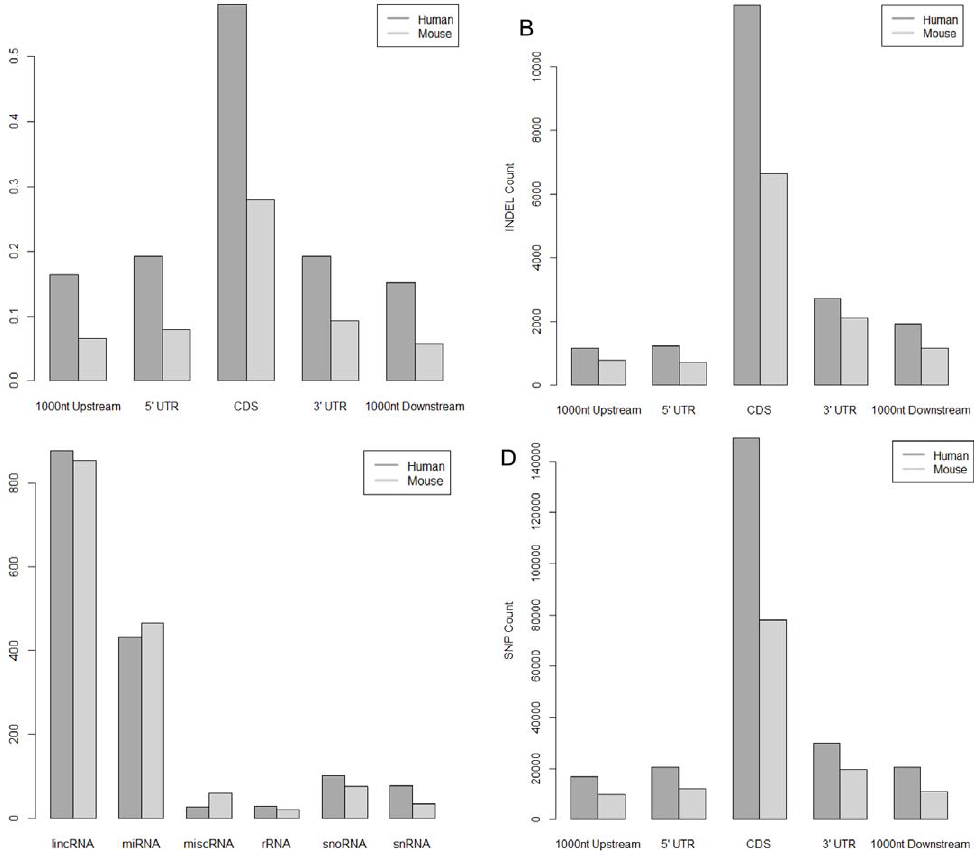
Figure 1. Distribution of mapped contigs. Histograms displaying the proportion of contigs mapped to particular features of protein coding genes of human and mouse (UTR is the untranslated region, and CDS is the coding sequence). The upper panel (A) displays the raw count and the lower panel (B) normalized values (the proportion discovered relative to how many could be discovered within each category). The raw count of SNPs (C) and Indels (D) mapped to particular features of protein coding genes of human and